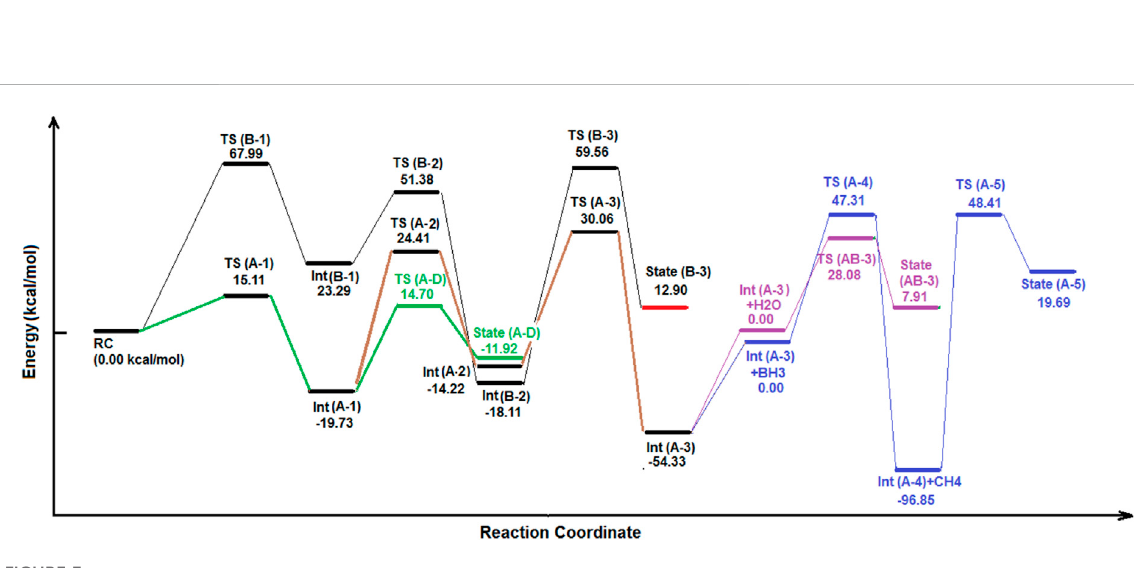
FIGURE 3 Energy diagram based on the reaction progress at B3LYP/6-311++G (d,p) level of theory.